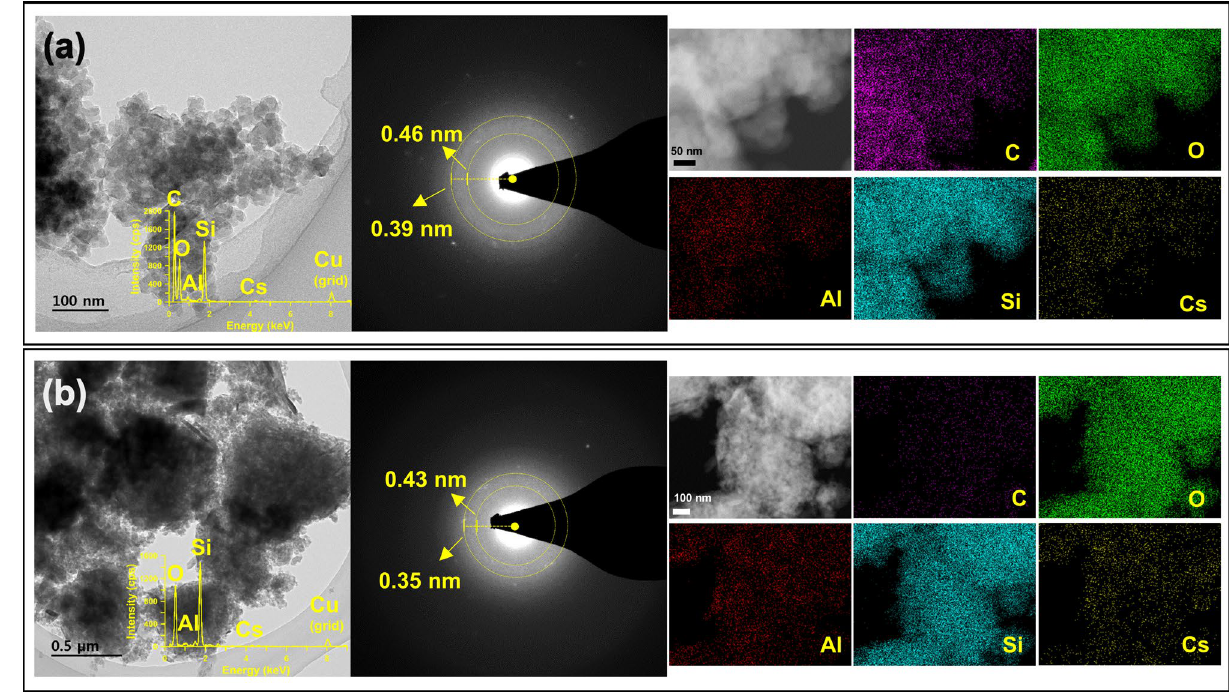
Figure 3. TEM-EDS images showing diffraction patterns and elemental mapping of Cs adsorption of the ( a ) acid-activated, and ( b ) base-activated, opaline mudstone.